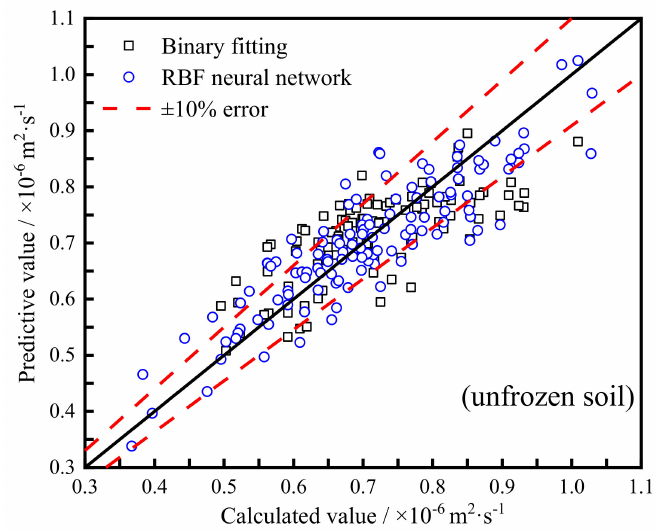
Figure 13. Comparison of prediction results of thermal diffusivity of unfrozen